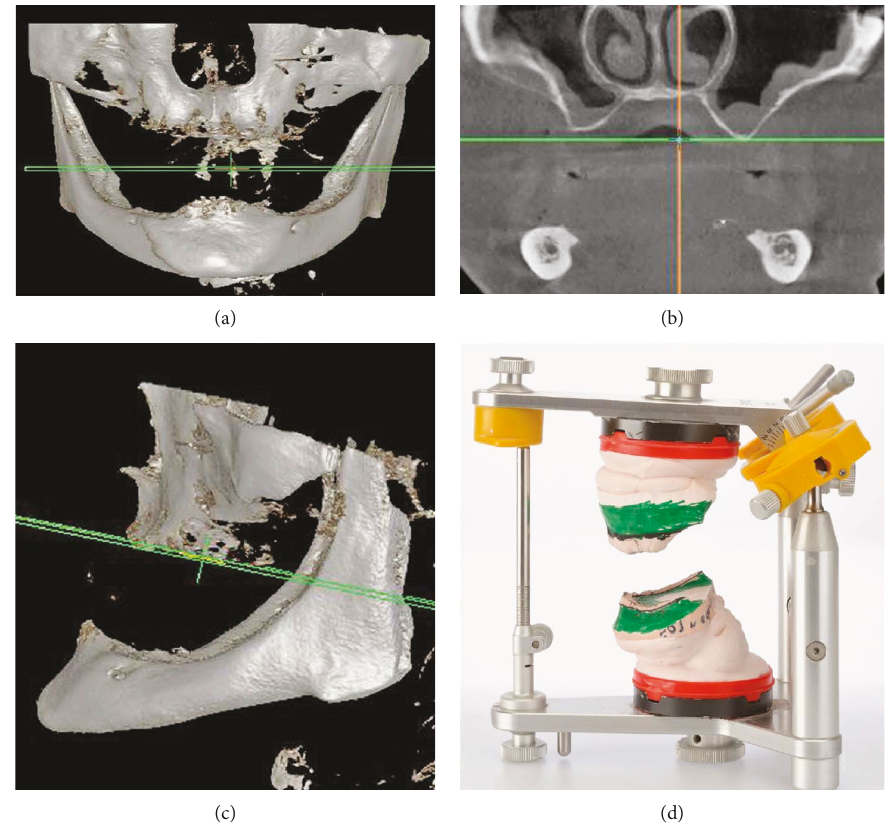
Figure 2: CBCT bone masking showing generalized advanced atrophy of the maxilla and posterior mandibular atrophy: (a) front view; (b) sinuses in sagittal section; (c) side view; (d) articulated casts show patient ’ s jaw